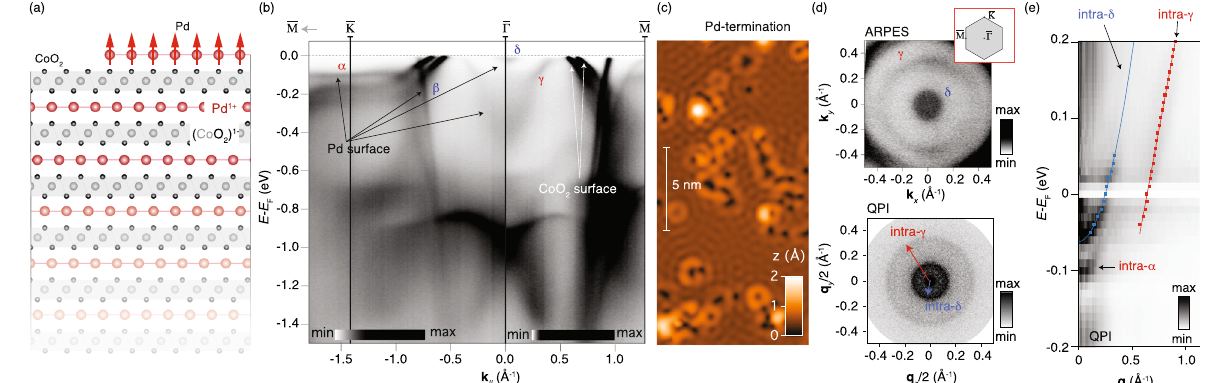
Fig. 1 Electronic structure of the Pd-terminated ferromagnetic surface of PdCoO 2 . a Schematic of the crystal structure (side view) of PdCoO 2 . After sample cleaveage, a CoO 2 surface termination (left) and a Pd termination (right) are both present. b ARPES spectra ( h ν = 80 eV along Γ -M ̄ and h ν = 82 eV along Γ -K ̄ ) show the superposition of spectral weight arising from both terminations. The labelled α - β and γ - δ bands derive from the Pd-terminated surface, and represent pairs which are exchange-split by a surface ferromagnetism. c STM topographic image of a Pd-terminated region. d The STM quasiparticle interference map (bottom) from a Pd-terminated region is in good agreement with the Fermi surface measured by ARPES (top), determined by the γ and δ bands. Signatures of such electron-like bands are also visible in energy- dependent QPI measurements ( e ) for intra- γ and intra- δ band scattering, reported together with the corresponding fi ts. Additional spectral weight at 0.1 eV binding energy can be attributed to intra- α band scattering, in good agreement with the fl at top of the α band observed by ARPES.